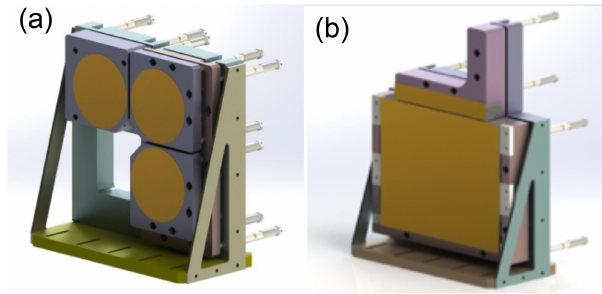
Figure 1. Schemes of the two mirror assemblies of MULTI- CHARME: the objective block (a) and the field block (b)